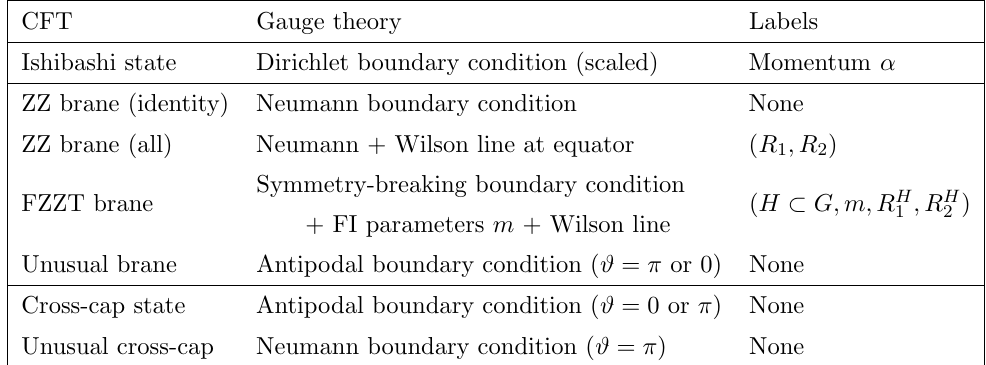
Table 1 . Correspondence between 3d N = 2 preserving boundary conditions for 4d N = 2 theories on the squashed hemisphere HS 4 and 2d CFT Ishibashi states, branes (Cardy states), and cross- b caps. ZZ branes are labeled by a fully-degenerate primary hence by a pair of representations of the Lie algebra. FZZT branes are labeled by semi-degenerate or non-degenerate primaries. The